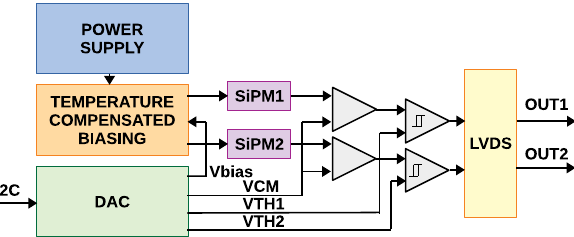
Fig. 2 SimplifiedblockdiagramoftheFEcard,showingitsmaincom-